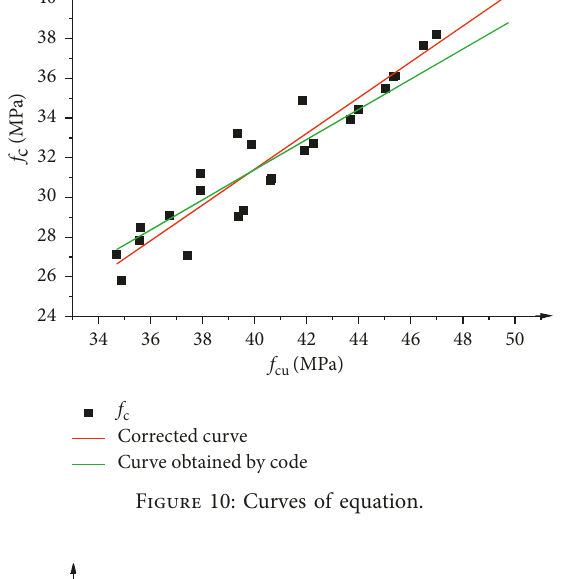
Figure 12: Curves of